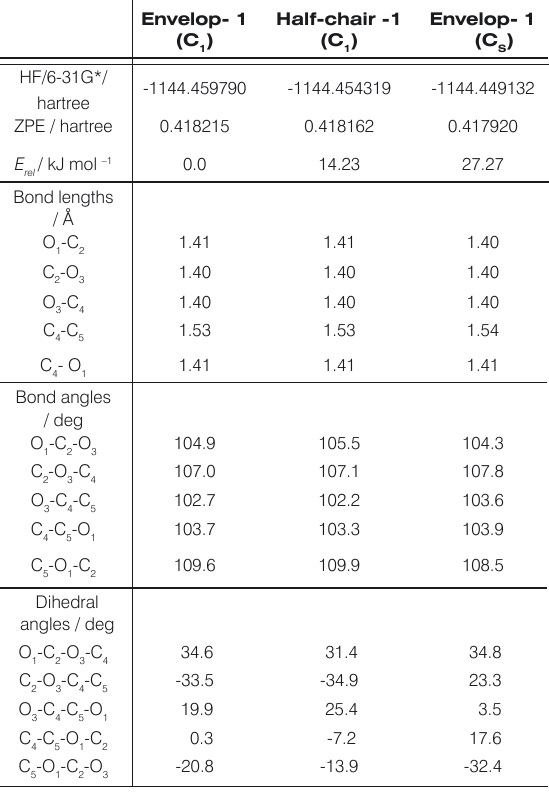
Table 1. Calculated heats of formation, total and zero-point vibrational energies (a) relative energy (b) for the conformations